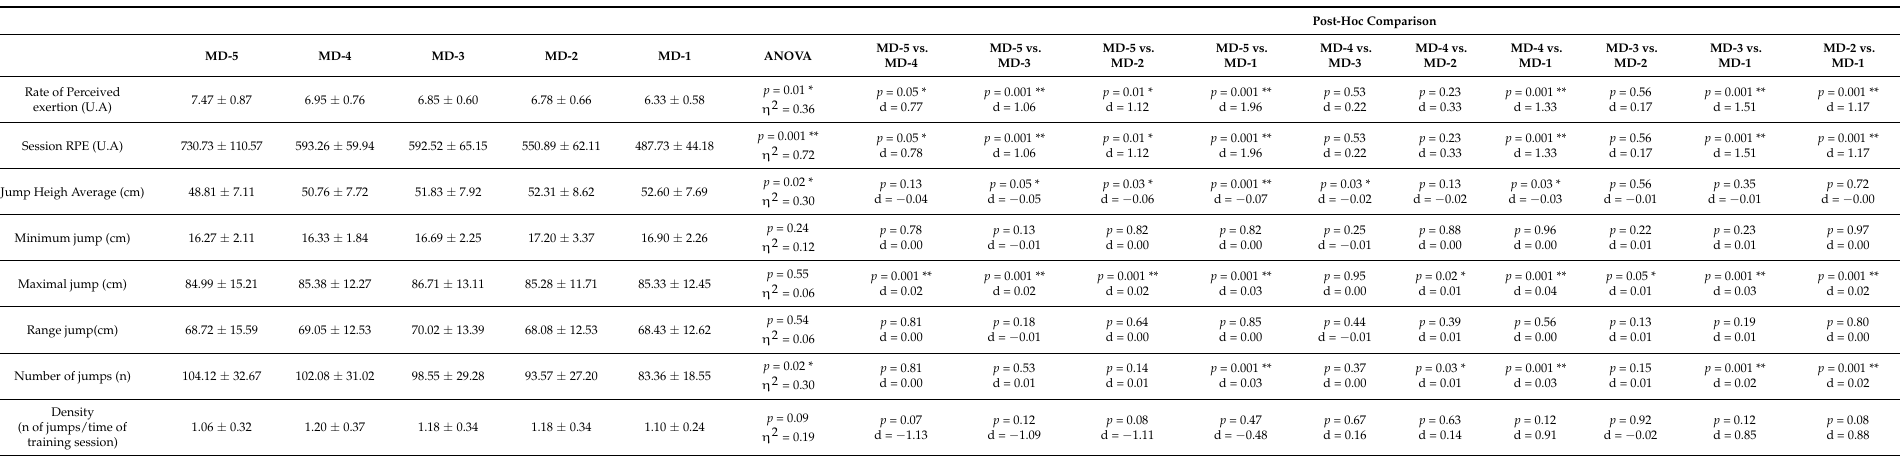
Table 1. Within-week variations (MD-5, MD-4, MD-3, MD-2, and MD-1) of (i) internal intensity: RPE and S-RPE, and (ii) external intensity: JHA, MJ, MXJ, RJ, NJ, and D (mean ±